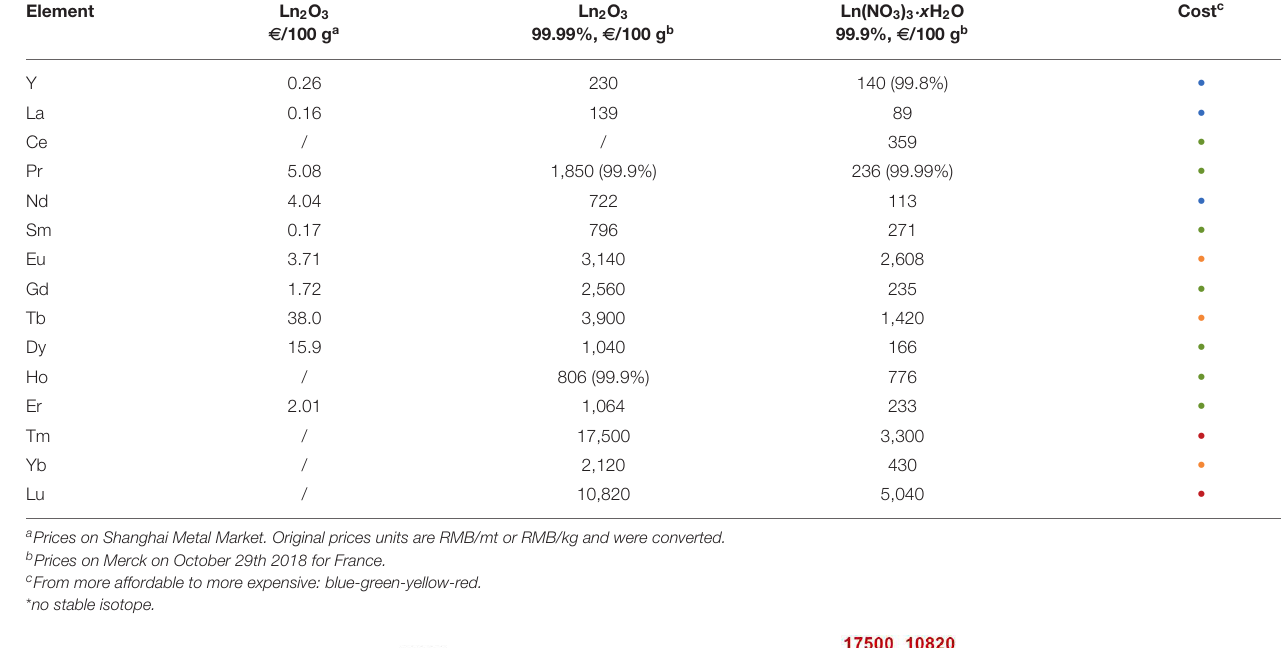
TABLE 2 | Lanthanide oxide and nitrate prices (October 2018).